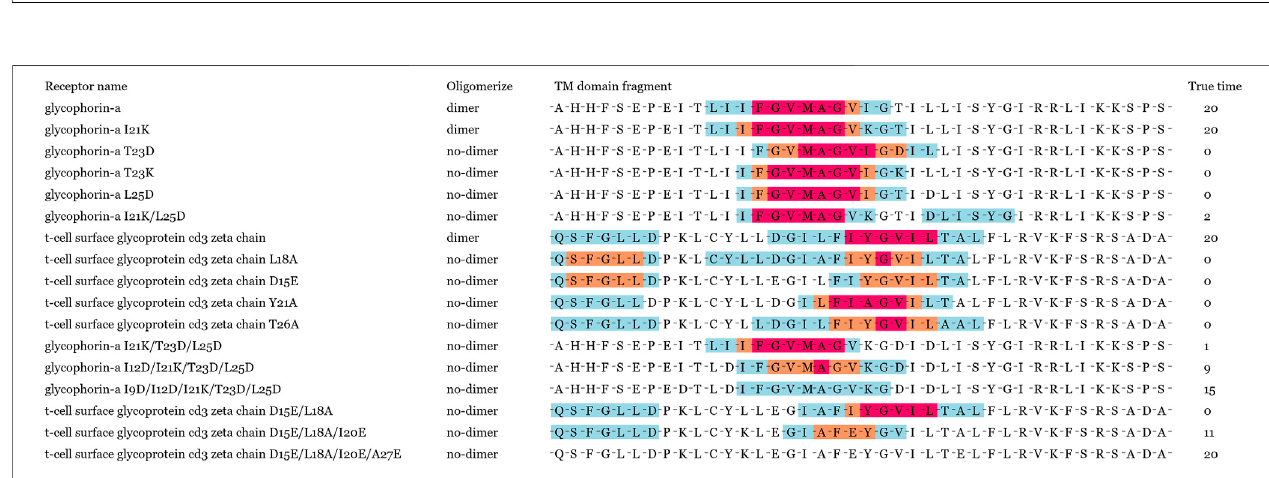
FIGURE 7 | Visualization results of 17 mutants. The labels of fi rst 11 mutants were con fi rmed in biological experiments, and the labels of last six mutants were speculated to be by their destroyed dimerization interface.